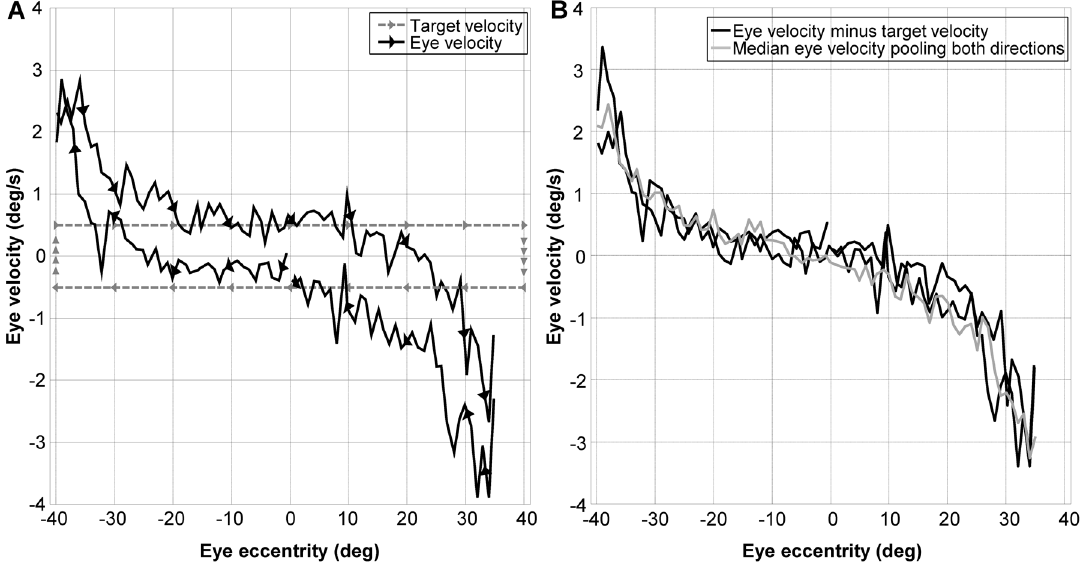
Figure 2. Position-Velocity plot considering target direction. Panel A - Black lines: Medians of the eye velocity within a 1 deg-wide bin plotted as a function of gaze eccentricity keeping the direction of target displacement separated. Gray lines: velocity of the target as a function of its position during the whole recording period. Note that the eye velocity matches the target velocity from the beginning suggesting that the offset observed around the straight ahead gaze is not due to a memory effect. The arrows show the directions of target and eye displacement. Panel B - Black lines: Velocity traces from the left panel after subtracting the correspondent target velocity. Gray line: Medians of the eye velocity within a 1 deg-wide bin plotted as a function of gaze eccentricity after pooling data from different directions of target displacement.